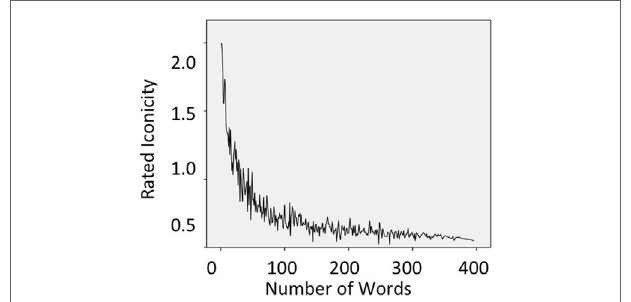
FigUre 7 | Mean-rated iconicity of the words that a child produced or understood as a function of the frequency of occurrence of the number of words the child produced or understood